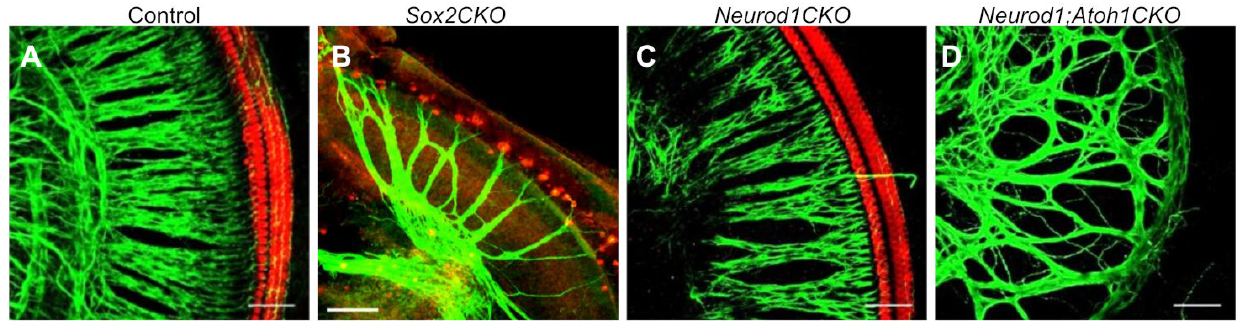
Figure 4. Differential innervation phenotype in the cochlea as the effect of the elimination of transcription factors. ( A ) Whole-mount immunostaining with anti-Myo7a (a marker of hair cells, HCs) and anti-ß-tubulin (nerve fibers) antibodies shows the innervation and the formation of the sensory epithelium and hair cells in the mouse control cochlea at postnatal day 0. ( B ) Delayed deletion of the SRY (sex-determining region Y)-box 2 ( Sox2 ) [41], ( C ) Neurod1 [6], and ( D ) double deletion of Neurod1 and Atoh1 [52] were generated by Isl1 Cre and result in abnormalities in the number of neurons, formation of sensory epithelium, and cochlear innervation. Scale bars, 50 µ m. ( D ) With permission from Reference